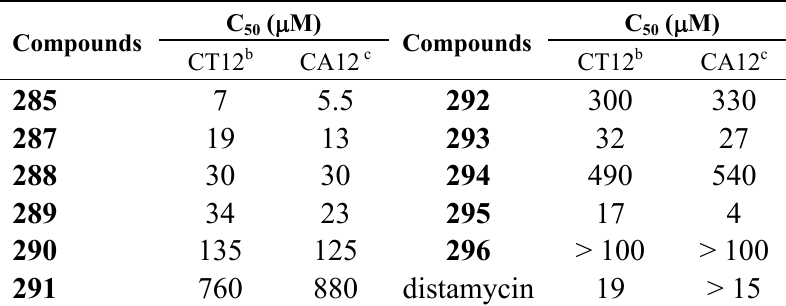
Table 23. Comparison of DNA binding affinities.